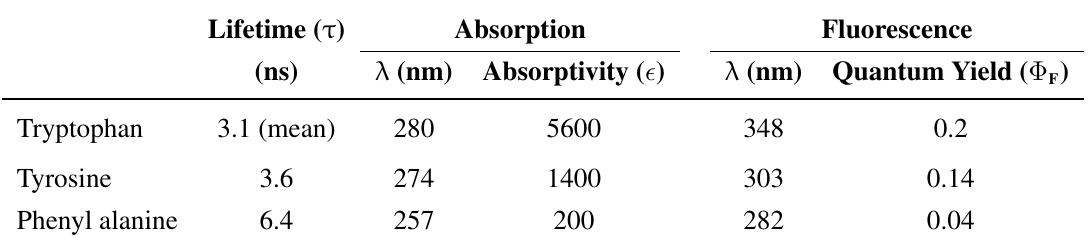
Table 1. Fluorescence properties of aromatic amino acids in water at neutral pH [2,15,21].